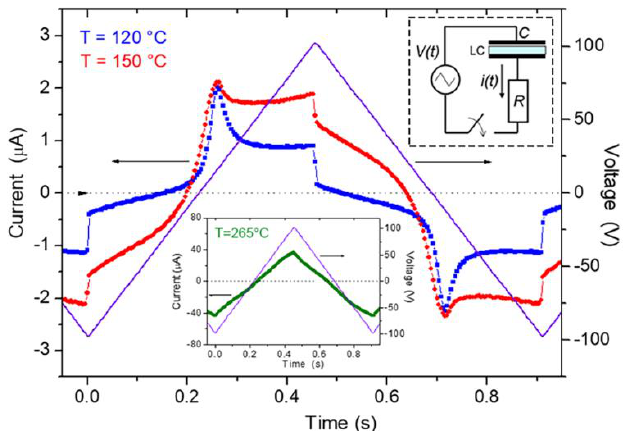
Figure 7. Repolarization current curves measured at three different temperatures, in the smectic C (SmC) (blue points), N (red points), and I (green points, in the inset) phases of BCM 2 (10 µm thick planar cell); the violet lines show the applied voltage. The upper inset shows the measurement circuit: V ( t ) is the applied triangular voltage waveform, i ( t ) is the circulating current, C is the capacitance of the LC cell, and R is the resistor across which the induced current is measured. Adapted from Francescangeli et al. [11]. Copyright © 2009 by WILEY-VCH Verlag GmbH & Co. KGaA. Reprinted by permission of WILEY-VCH Verlag GmbH & Co. KGaA.